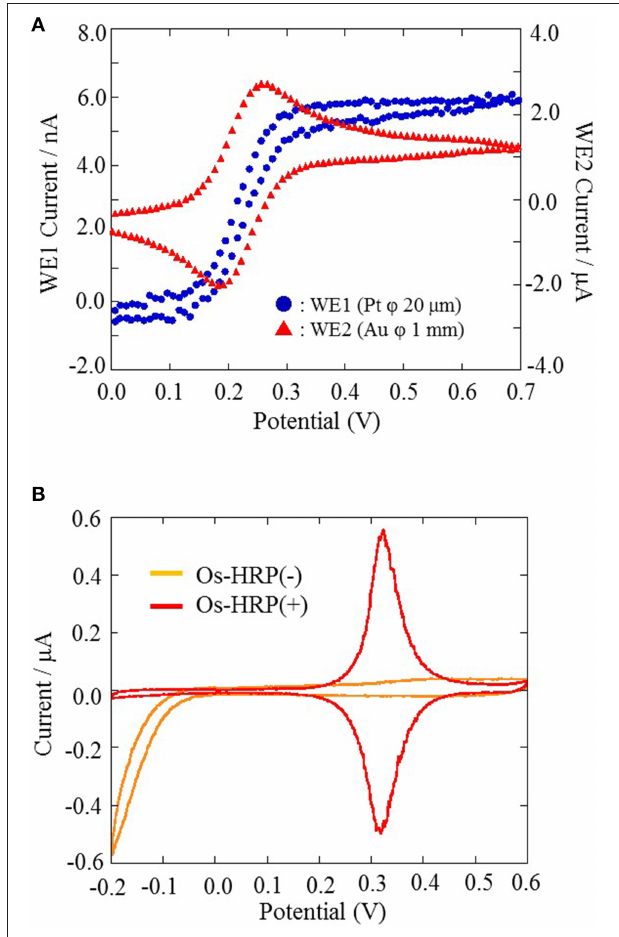
FIGURE 3 | The characterization of Pt microelectrode and Au electrode performed using cyclic voltammetry at a scan rate of 20 mV/s from 0.0 to + 0.7 V at room temperature (A). The characterization of Os-HRP modified Au electrode conducted at a scan rate of 20 mV/s from − 0.2 to + 0.6 V at room temperature (B)